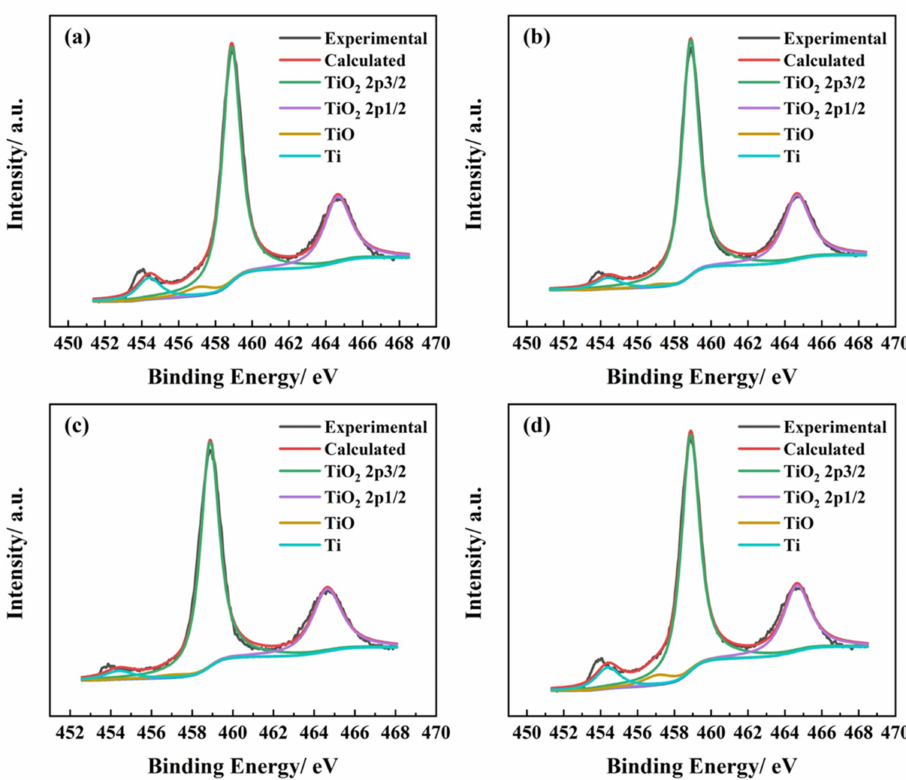
Figure 11. Detailed Ti2p XPS spectra of TA2 in simulated seawater with different pH values: